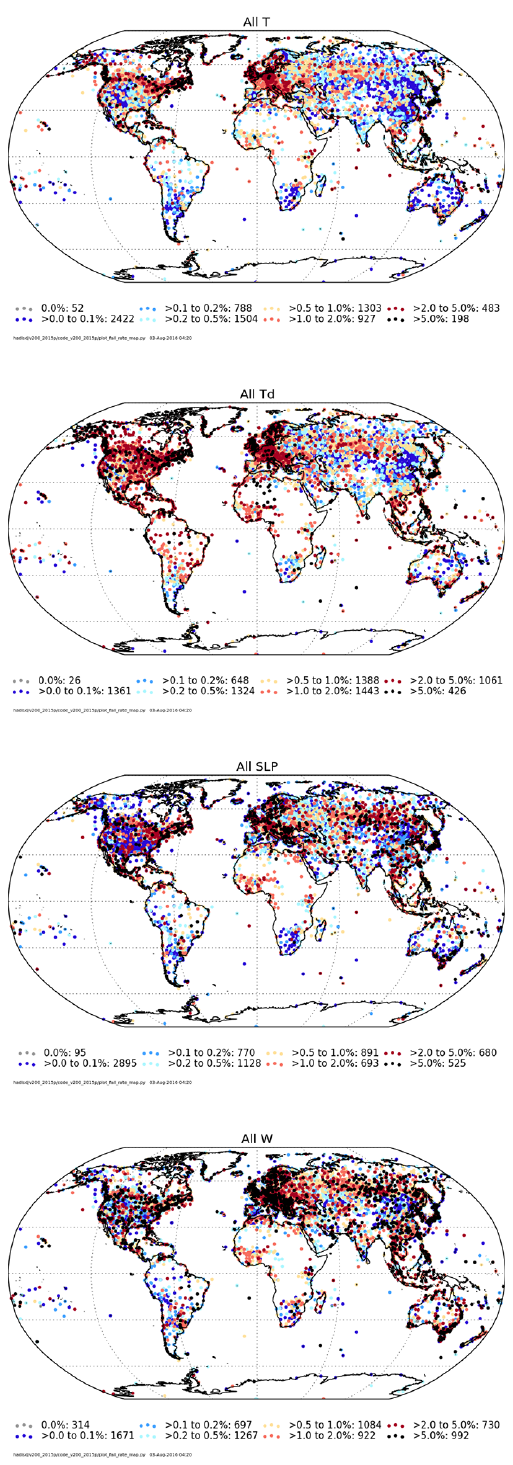
Figure 6. Rejection rates by variable for each station showing the temperature, dew point temperature, sea-level pressure and wind speed. Different rejection rates are shown by different colours, and the legend also shows the number of stations in each category. The stations with a greater proportion of observations flagged are plotted on